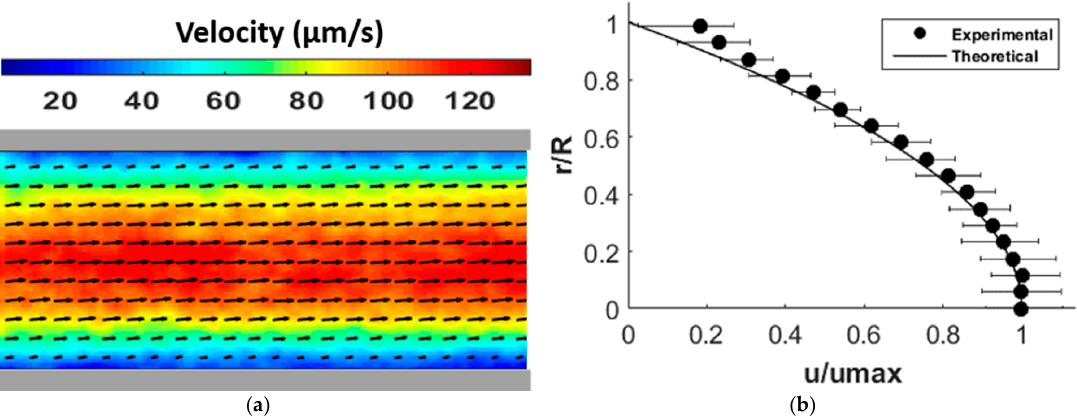
Figure 2. ( a ) Velocity distribution of pressure-driven flow with a volume flow rate of 12 µL/h through a microchannel 0.3 mm in diameter; ( b ) validation of the pressure-driven velocity field in ( a ).